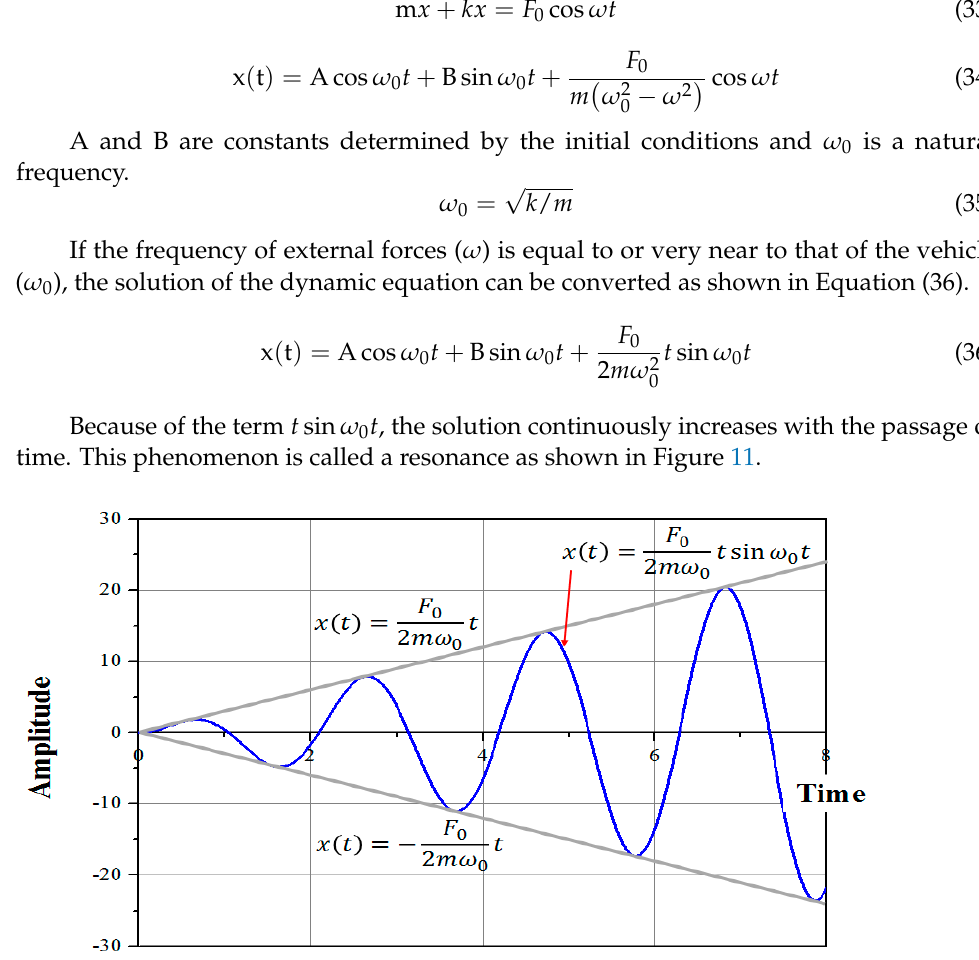
Figure 11. The amplitude under a resonance